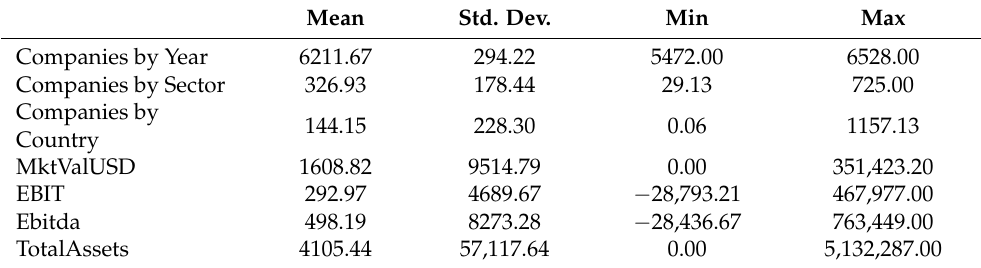
Table 1. Descriptive